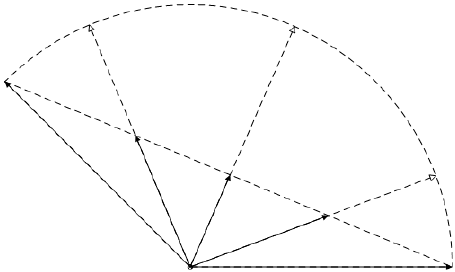
Figure 6. Linear orientation interpolation on arc length when interpolation over 1/4 intervals.